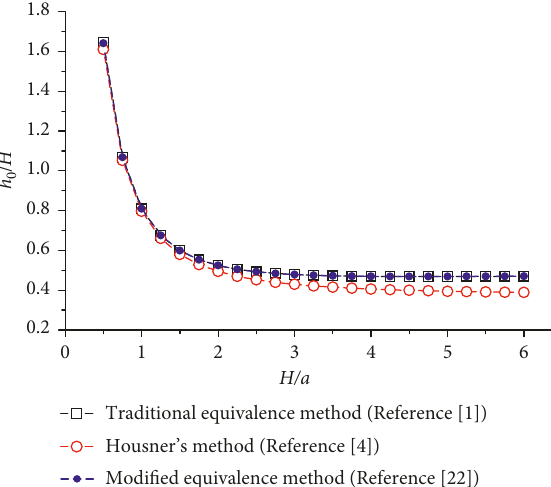
Figure 6: Position ratio h (rectangular tank).